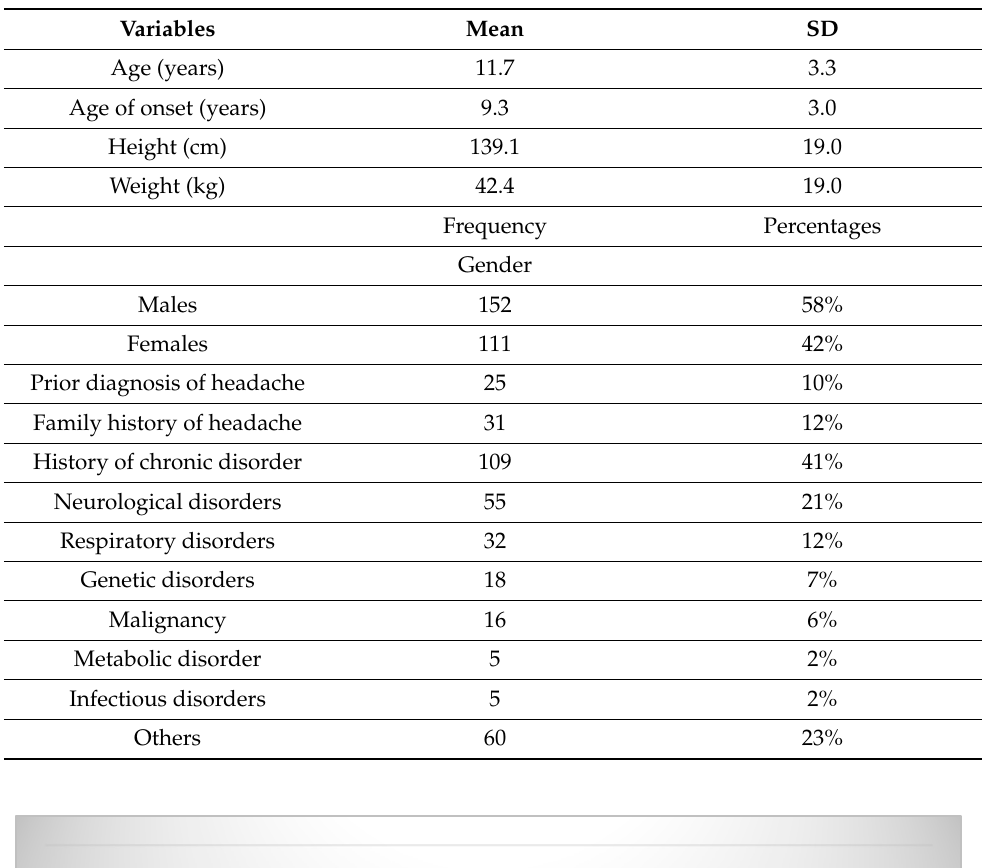
Table 1. Basic demographics of children presenting to the ER with headache (n = 263).